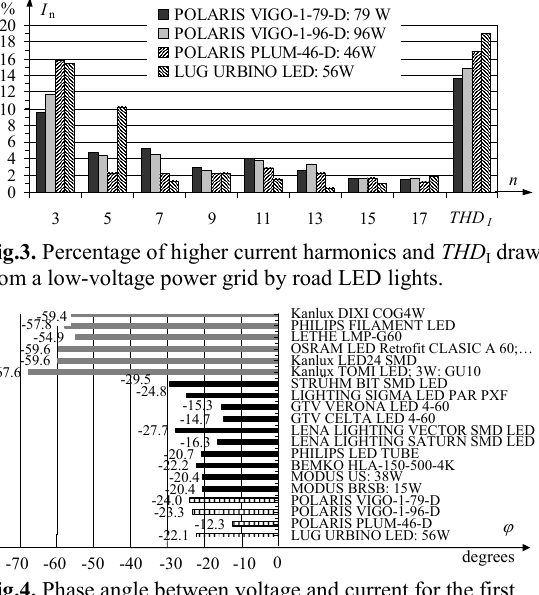
Fig.4. Phase angle between voltage and current for the first harmonic in the tested LED bulbs.